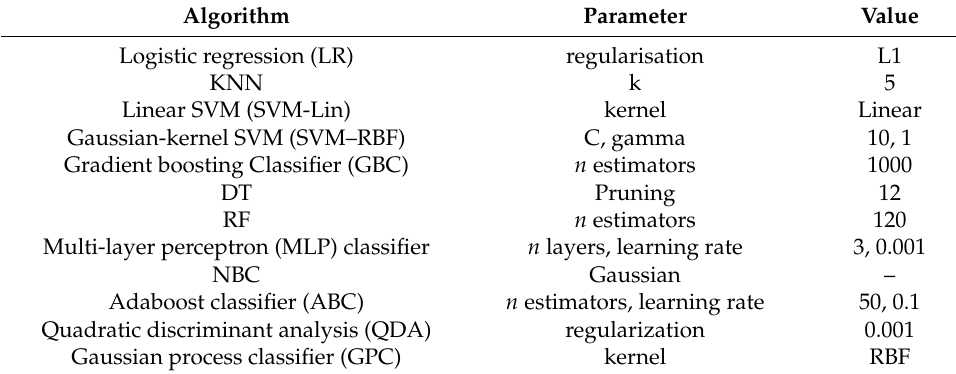
Table 2. Optimal parameters for classifiers.